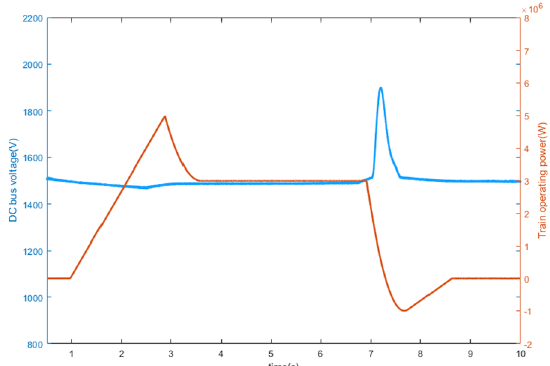
Fig. 11 Simulation waveform diagram of the traditional rail transit energy router control